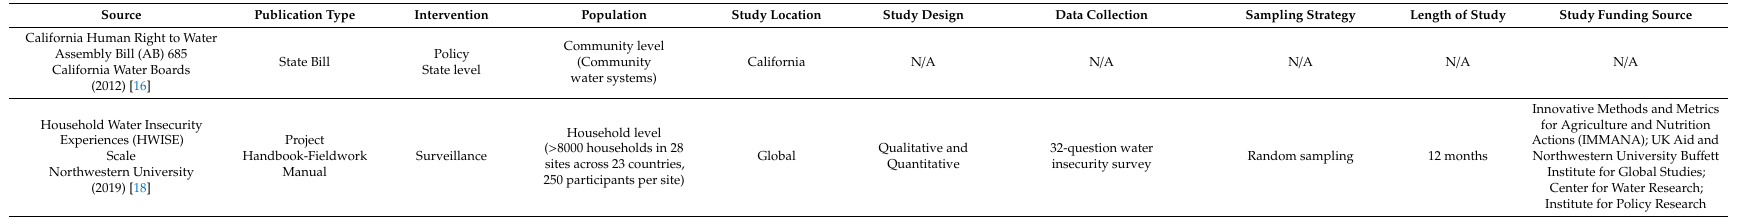
Table A3. Literature Catalogue: Characteristics of Studies Included in the Water Security Systematic Review